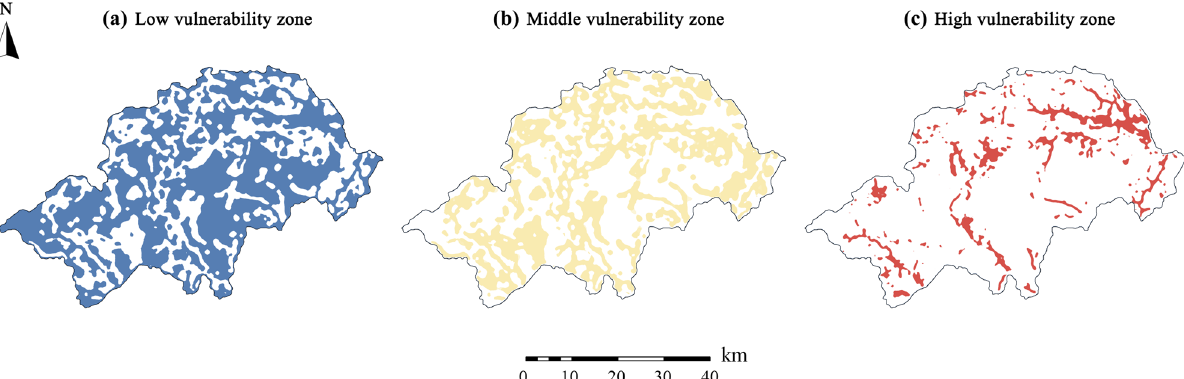
Figure 9. Schematic diagram of ecological environment improvement. ( a ) Low vulnerability zone mainly includes the micro and Mild vulnerability areas in the evaluation results. ( b ) Middle vulnerability zone is the transitional zone, which is mainly composed of the surrounding area of the ecological source or the low- impedance area. ( c ) High vulnerability zone mainly includes the severe and extreme vulnerability areas in the evaluation